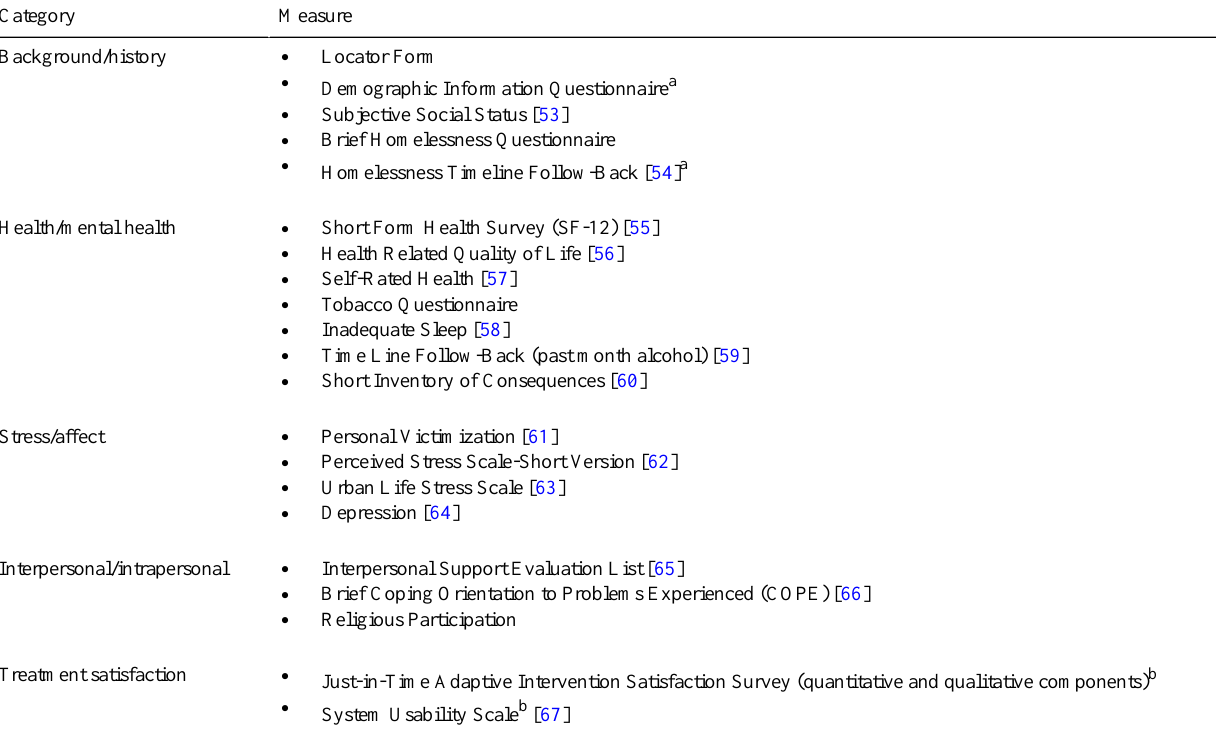
Table 2. In-person assessment